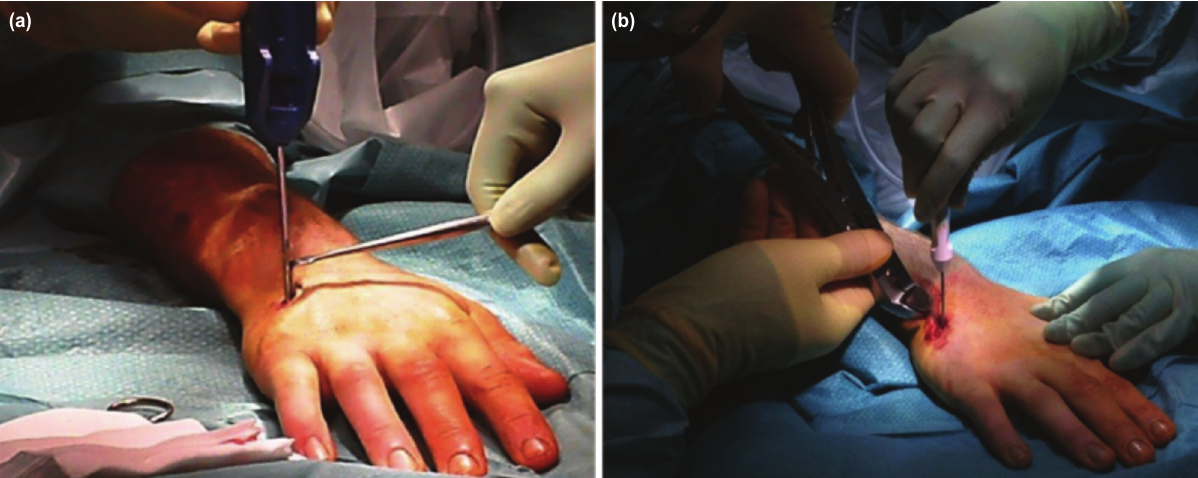
(a) The awl is gently advanced into the dorsal cortex and the metacarpal nail is passed via the awl into the medullary canal, up Fig. 2: to the fracture site. Following manipulation and radiological confirmation of reduction, the nail is advanced beyond the fracture site to the subchondral bone. (b) Proximal locking is achieved by introducing the cannulated pin into the end of the bent nail and advancing it into the metacarpal base.